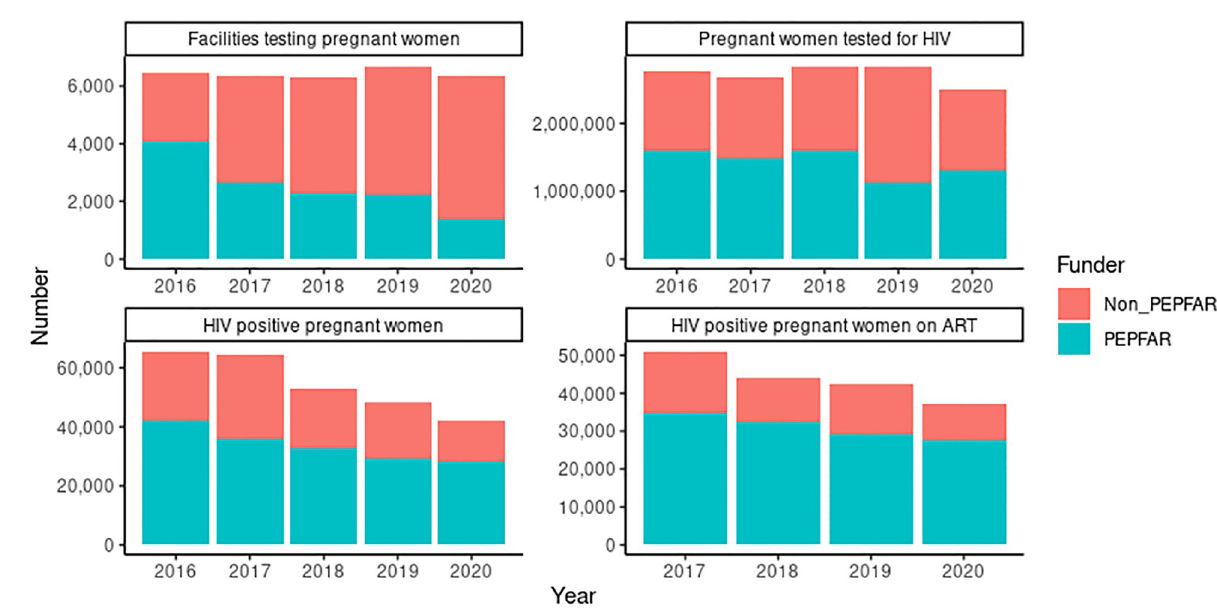
Fig 11. Comparison between PMTCT facilities and services by funder.